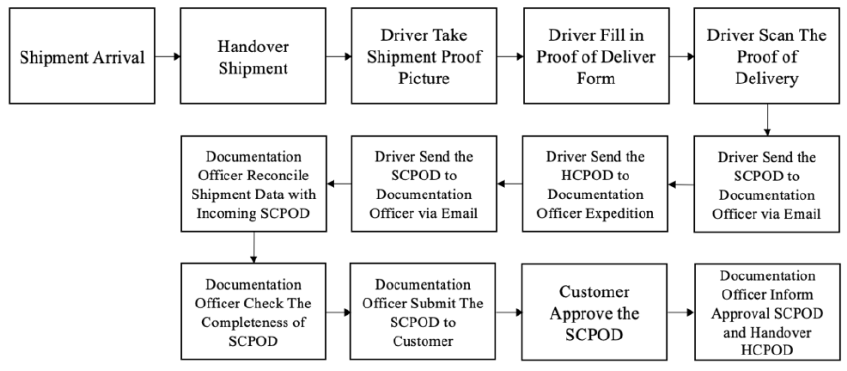
Figure 1: Proof of Delivery Work Flow in PT.